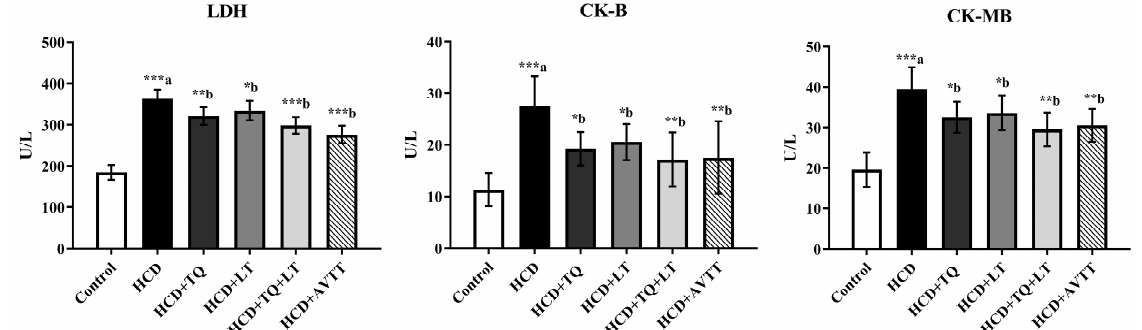
Figure 2. Effect of thymoquinone (TQ), losartan (LT) and their combination on high-cholesterol diet (HCD)-induced changes in serum lactate dehydrogenase (LDH), creatine kinase-B (CK-B) and creatine kinase-MB (CK-MB) levels. Data are expressed as Mean ± SE ( n = 6) and analyzed using one-way ANOVA followed by Student–Newman–Keuls as post hoc test. a Control vs. HCD group; b HCD vs. QT or LT or QT + LT. p values considered significant when * p < 0.05, ** p < 0.01 and *** p < 0.001.